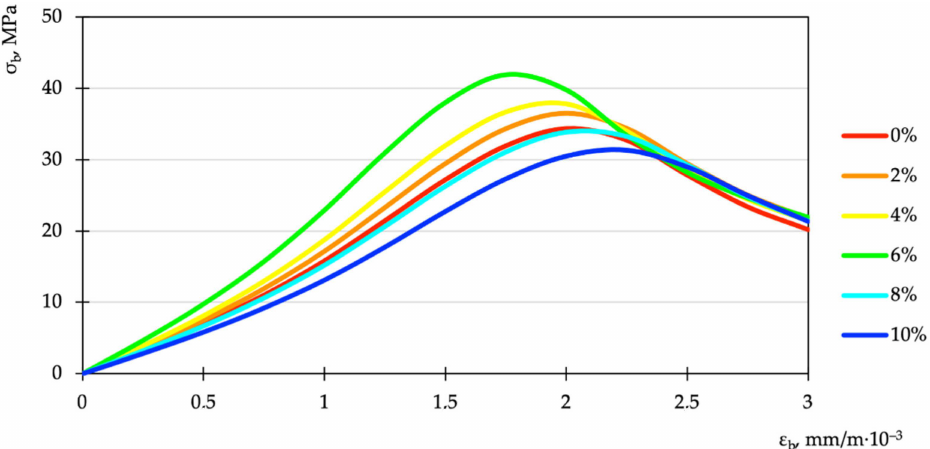
Figure 12. Stress-strain diagram in